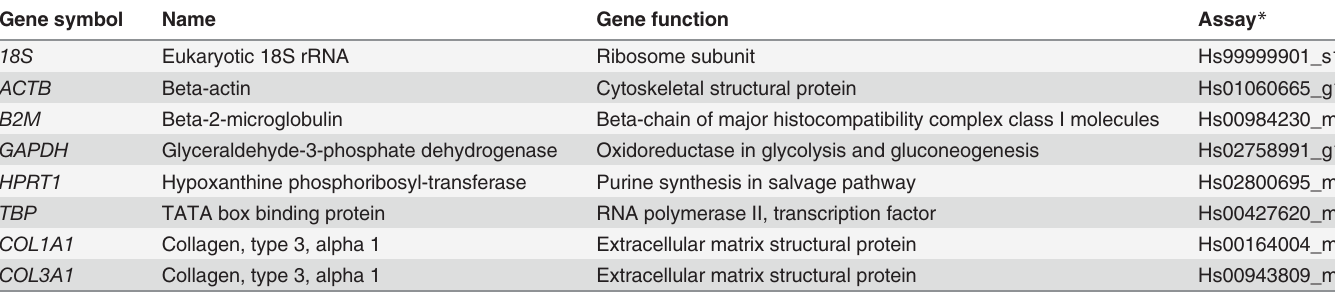
Table 2. Summary of six reference genes and target